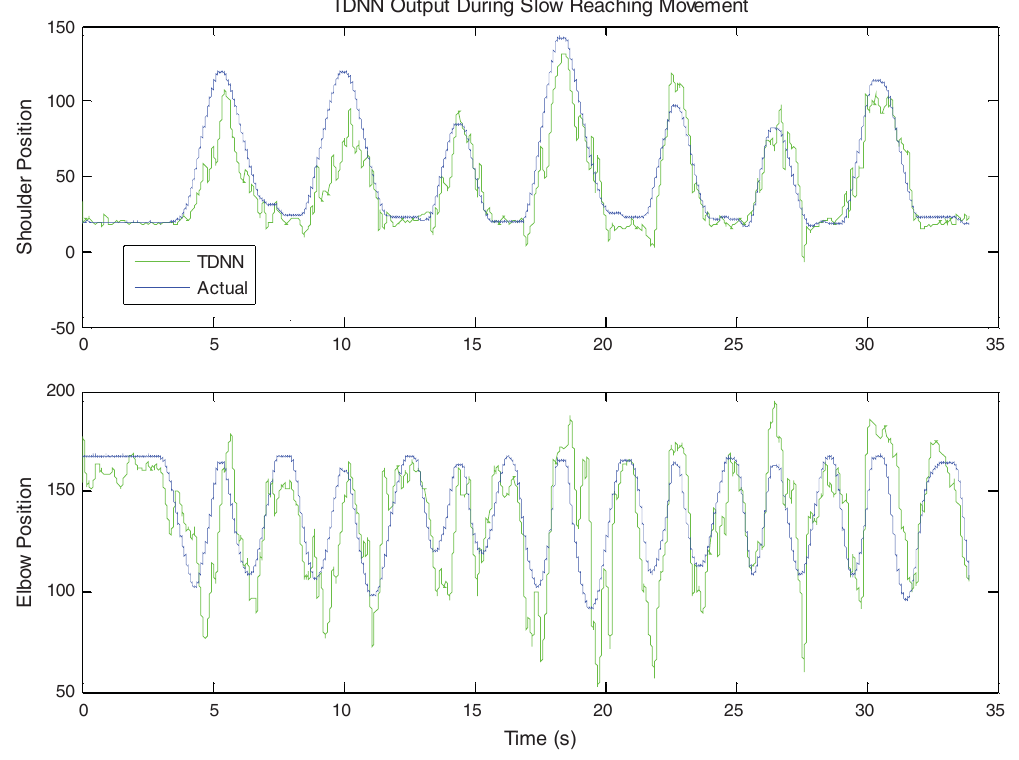
Fig. 12. The output of the TDNN during slow reaching movement for Subject